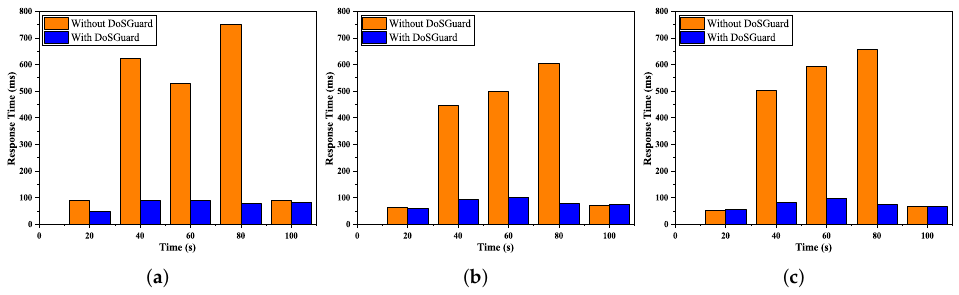
Figure 7. Defense effects on application response time. ( a ) Fake source MAC address. ( b ) Fake source IP address. ( c ) Fake source port